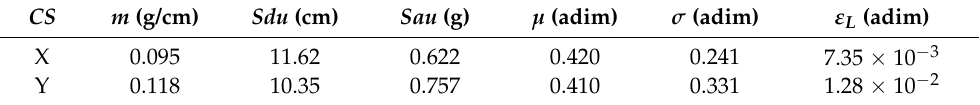
Table 3. Parameters of the parametric model for the capacity spectra ( CS ) in the X and Y axes. CS CS m